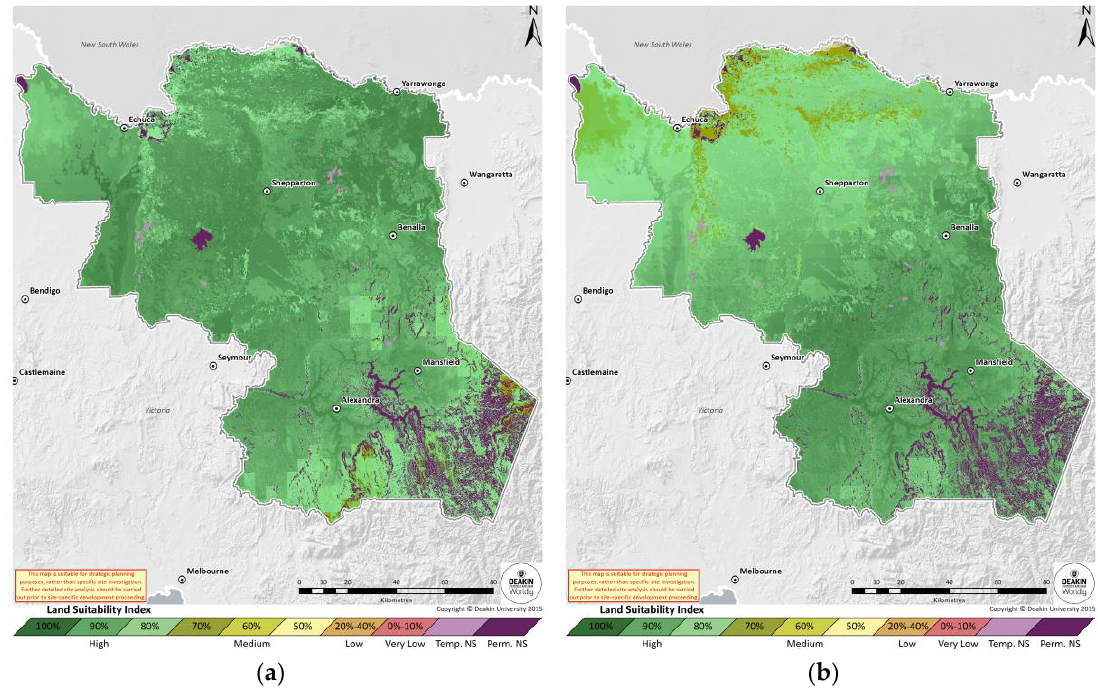
Figure 6. Fitted Analytical Hierarchy Process Fuzzy Set Membership model for ( a ) climate normal ( b ) 2050.